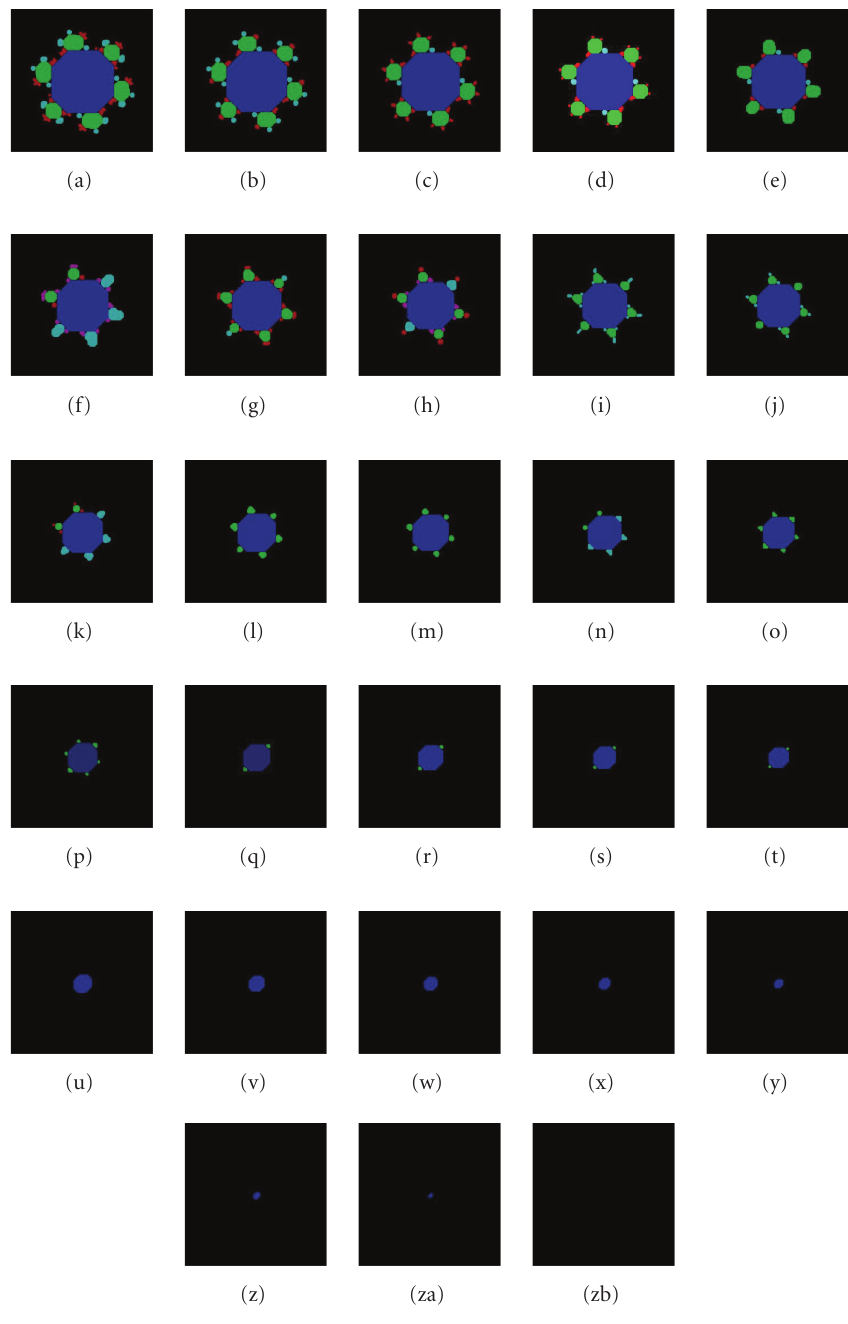
Figure 3.4. Pore-body network from eroded versions of fractal